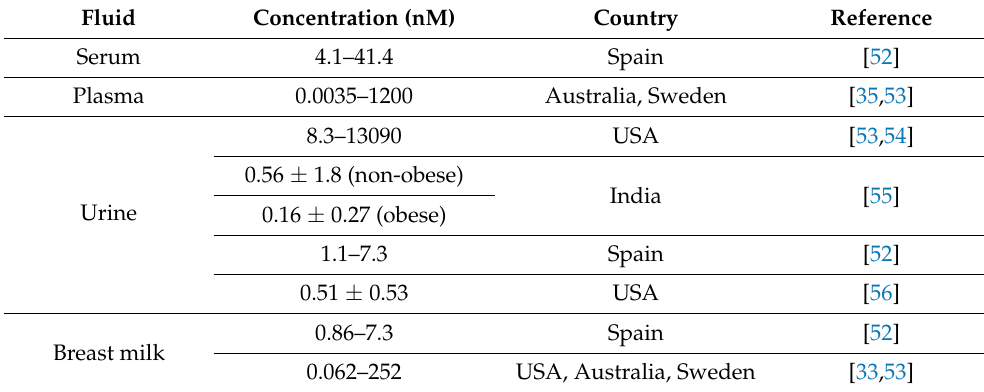
Table 4. TCS concentrations in biological